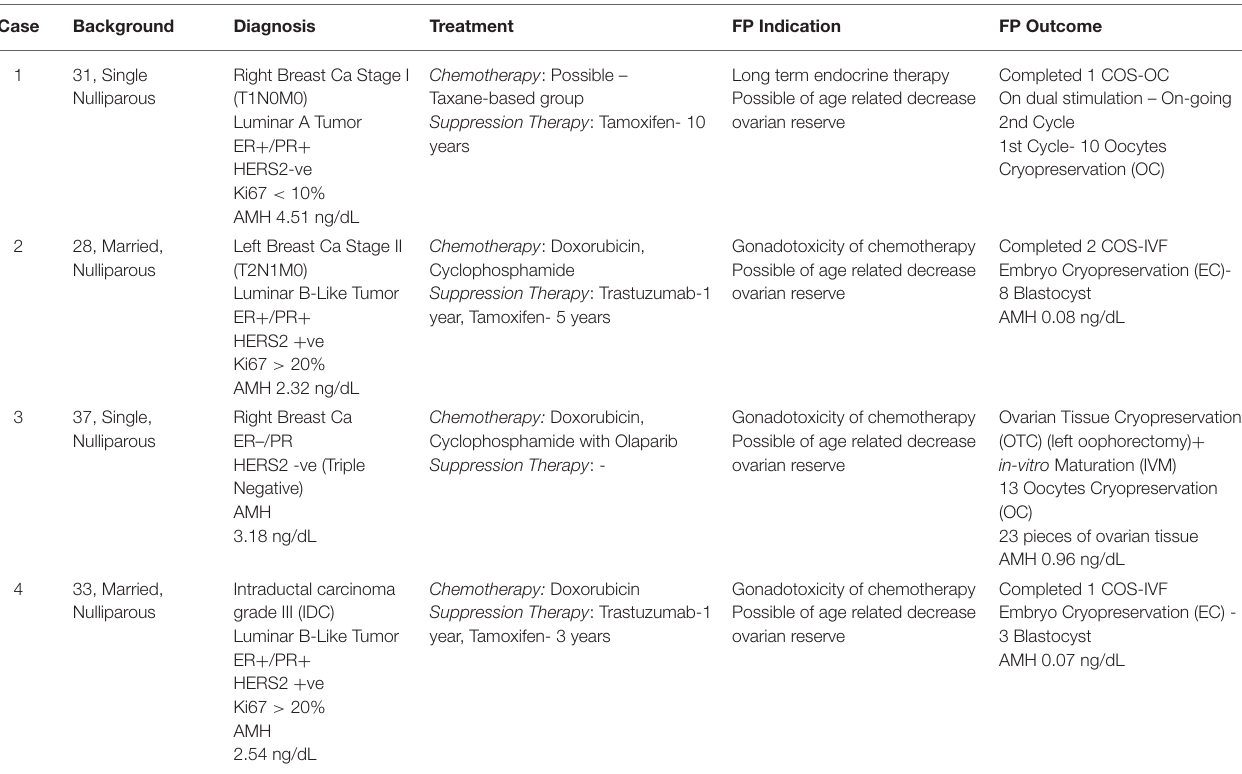
TABLE 1 | The summary of main characteristics and reproductive